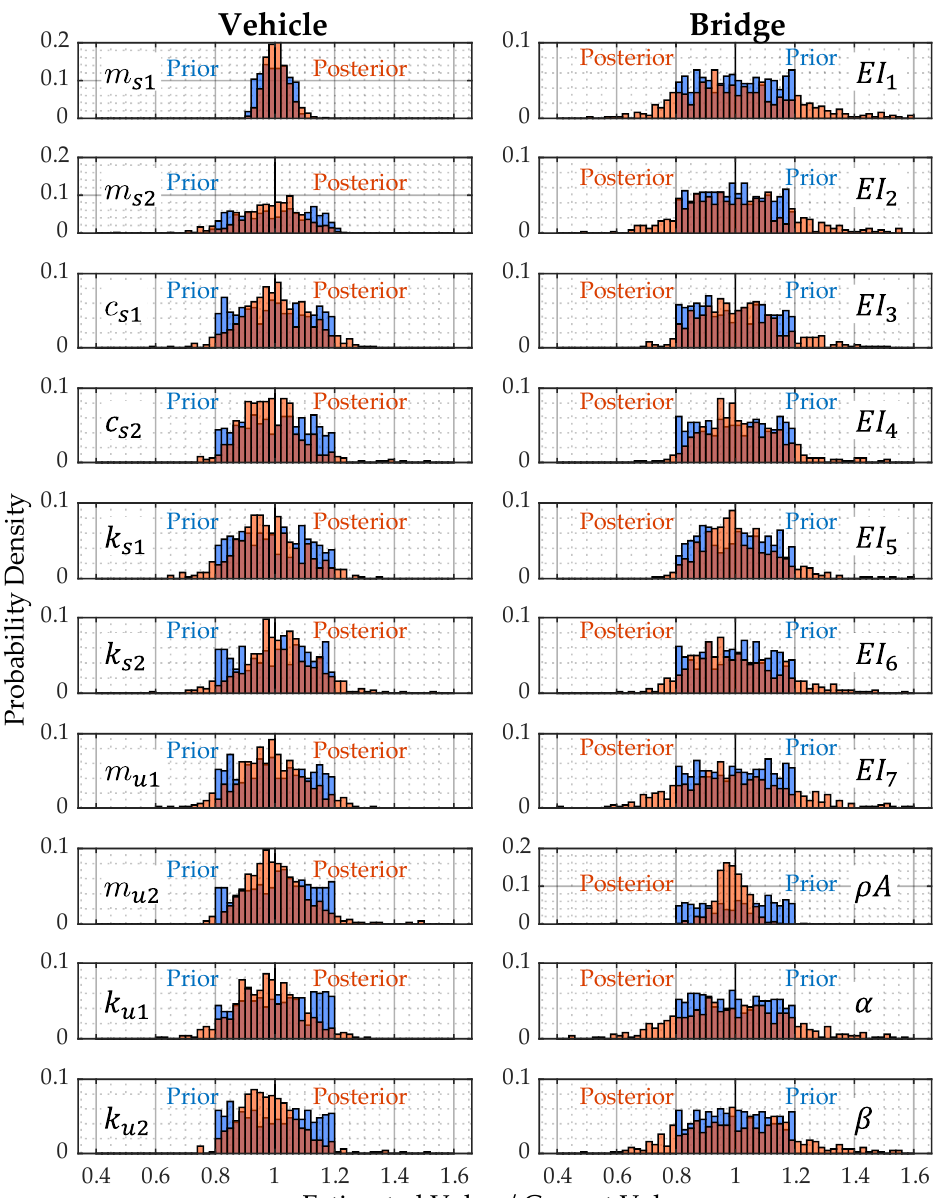
Figure 9. The application results of the PRE method in Scenario 1: these figures indicate the prior and posterior probability density distributions of the estimated mechanical parameters. The blue bars represent the prior information assuming uniform probability distributions. The red bars represent the posterior information updated by the MCMC process. The left and right indicate the vehicle and bridge mechanical parameters,